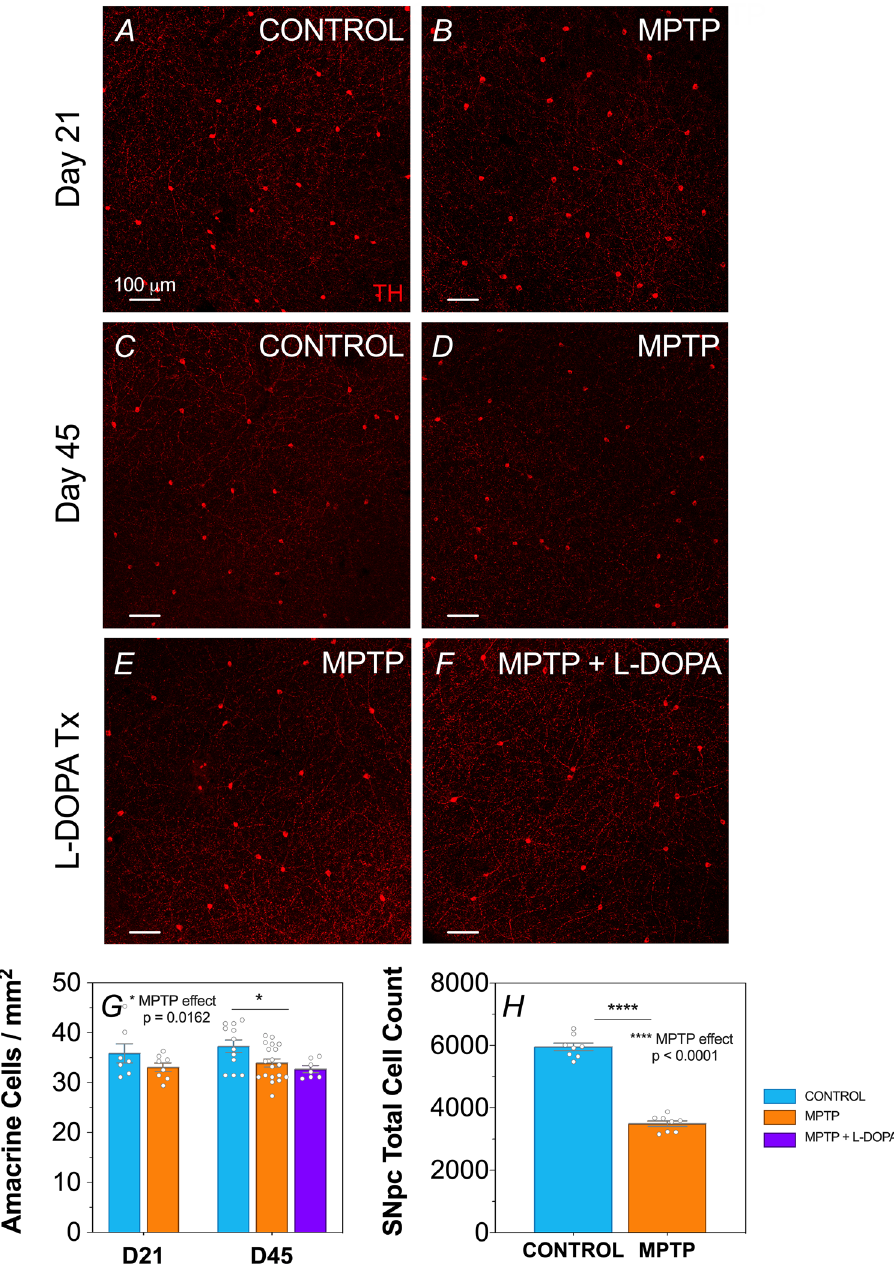
Figure 1. Effect of MPTP and L-DOPA on retinal and substantia nigral dopaminergic neurons. Representative retinal flatmount images of dopaminergic tyrosine hydroxylase (TH) positive amacrine cells at × 10 magnification of Day 21 ( A , B ), Day 45 ( C , D ) and Day 45 L-DOPA treatment (Tx) ( E , F ) cohorts. Scale bar = 100 μm. Group average (± SEM) TH-positive amacrine cell counts ( G ) of all treatment groups and total substantia nigral (SNpc) cell counts ( H ) of control vs. MPTP-treated animals at Day 45. Day 21 cohort (D21): control (n = 7, blue) vs. MPTP (n = 8, orange). Day 45 cohort (D45): control (n = 12, blue) vs. MPTP (n = 19, orange) vs. MPTP + L-DOPA (n = 7,